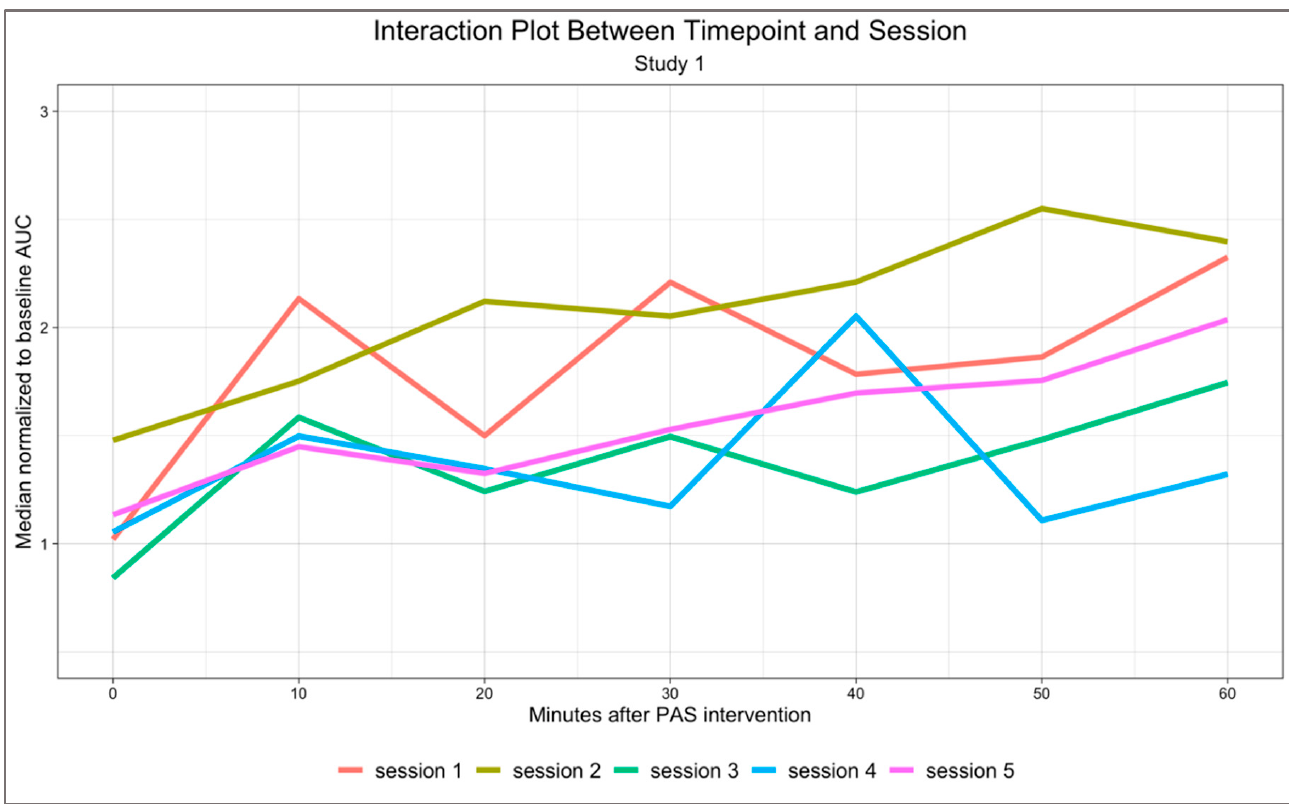
Figure 2. Interaction plot of Study 1. Significant effect of timepoint (F = 6.884, p < 0.0001). No significant session (F(4, 28) = 1.583, p = 0.206, η p2 = 0.184) or timepoint by session (F(24, 168) = 1.235, p = 0.219, η p2 = 0.150) interaction.